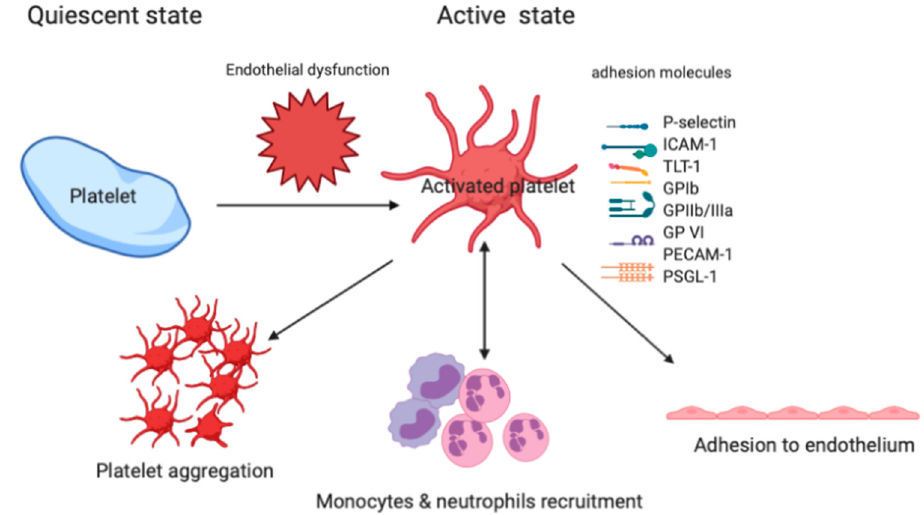
Figure 3. The role of specific adhesion molecules in the platelet-neutrophil interaction, adhesion to endothelium, and platelet aggregation. Triggering receptor expressed on myeloid cells (TREM)-like transcript-1: TLT-1; intercellular adhesion molecule-1: ICAM-1; P-selectin glycoprotein ligand 1: PSGL-1; glycoprotein: GP; Platelet and endothelial cell adhesion molecule-1: PECAM ‐ 1.